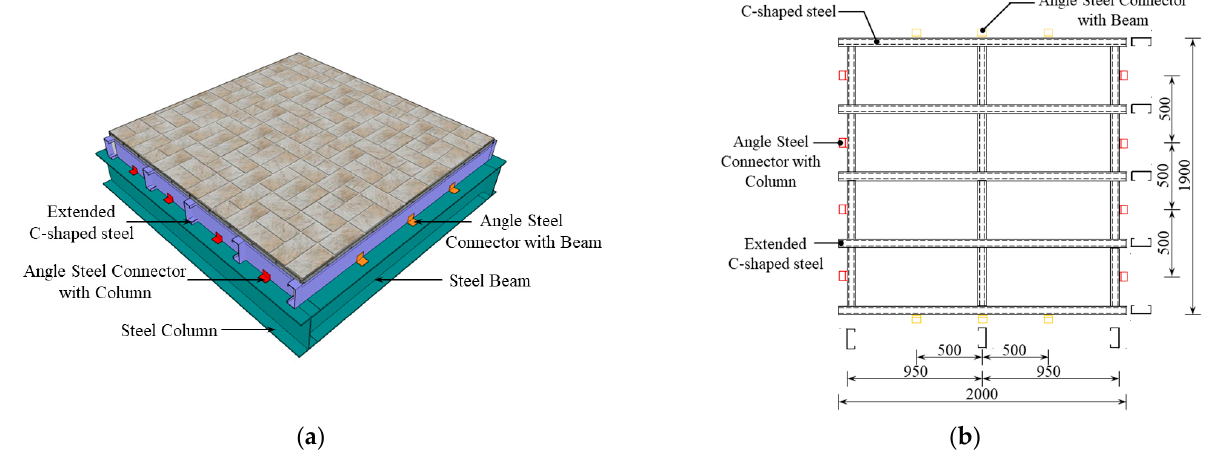
Figure 2. The structure ( a ) the steel-frame composite wallboard shear wall; ( b ) the arrangement of the angle steel connector and the C-shaped steel of the composite wallboard.